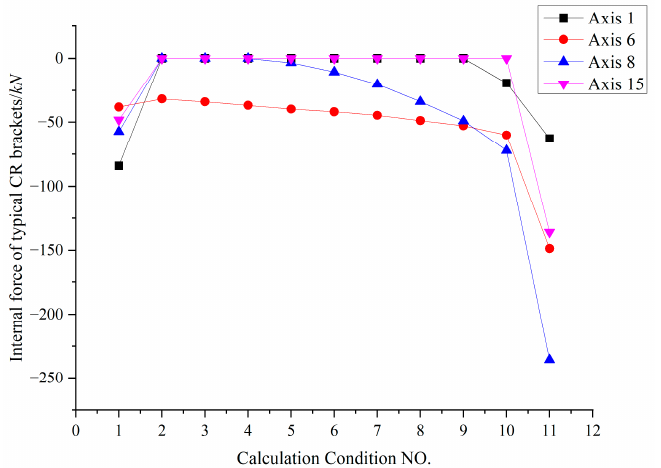
Figure 21. Variation curve of internal force of typical inner CR brackets.